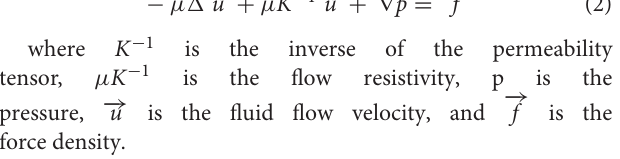
Frontiers in Water |